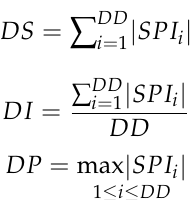
calculated for each grid cell in the study area, with emphasis on drought duration ( DD ), drought severity ( DS ), drought intensity ( DI ), and drought peak ( DP ). DD refers to the number of months between the time the drought began and the time the drought ended. DS refers to the absolute value of SPI cumulative value during the drought event, and the calculation method is shown in Equation (1). DI refers to the average value of SPI during the drought event, which is the ratio of the DS to the DD , as shown in Equation (2). DP , shown in Equation (3), refers to the absolute value of the minimum SPI value during the drought event, and its corresponding time is the drought peak time (DPT).